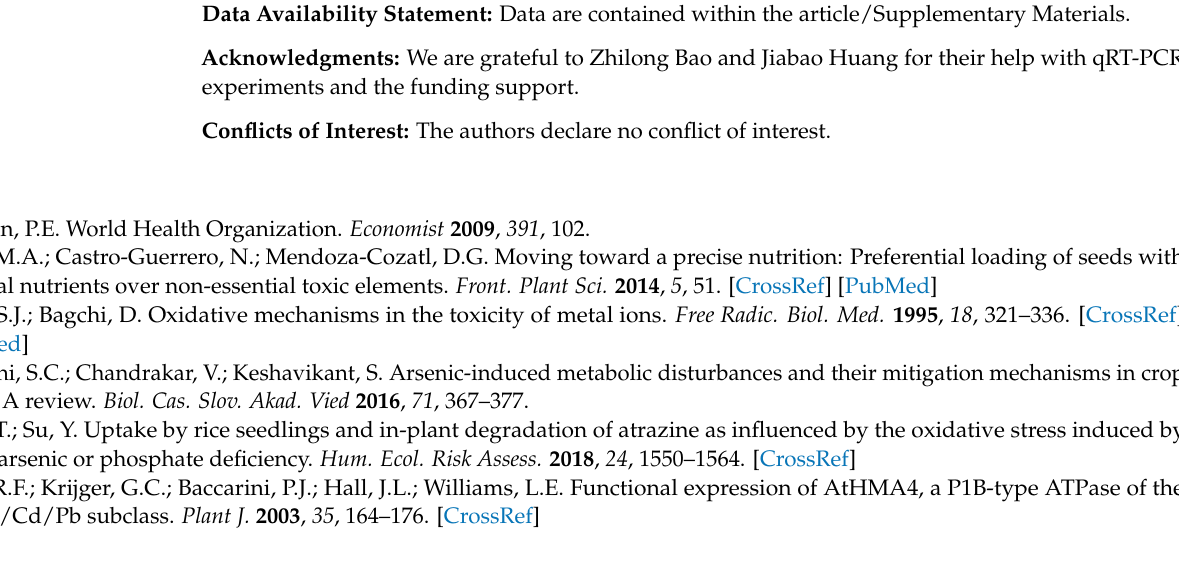
pollination. Table S5: List of PPIs extracted from the STRING database. Table S6: The primers used in the